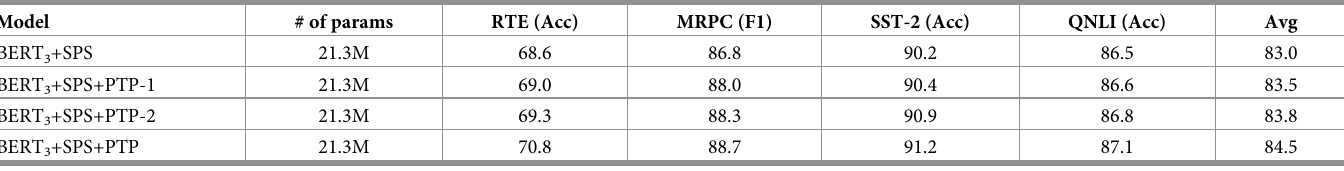
The results are derived using GLUE dev